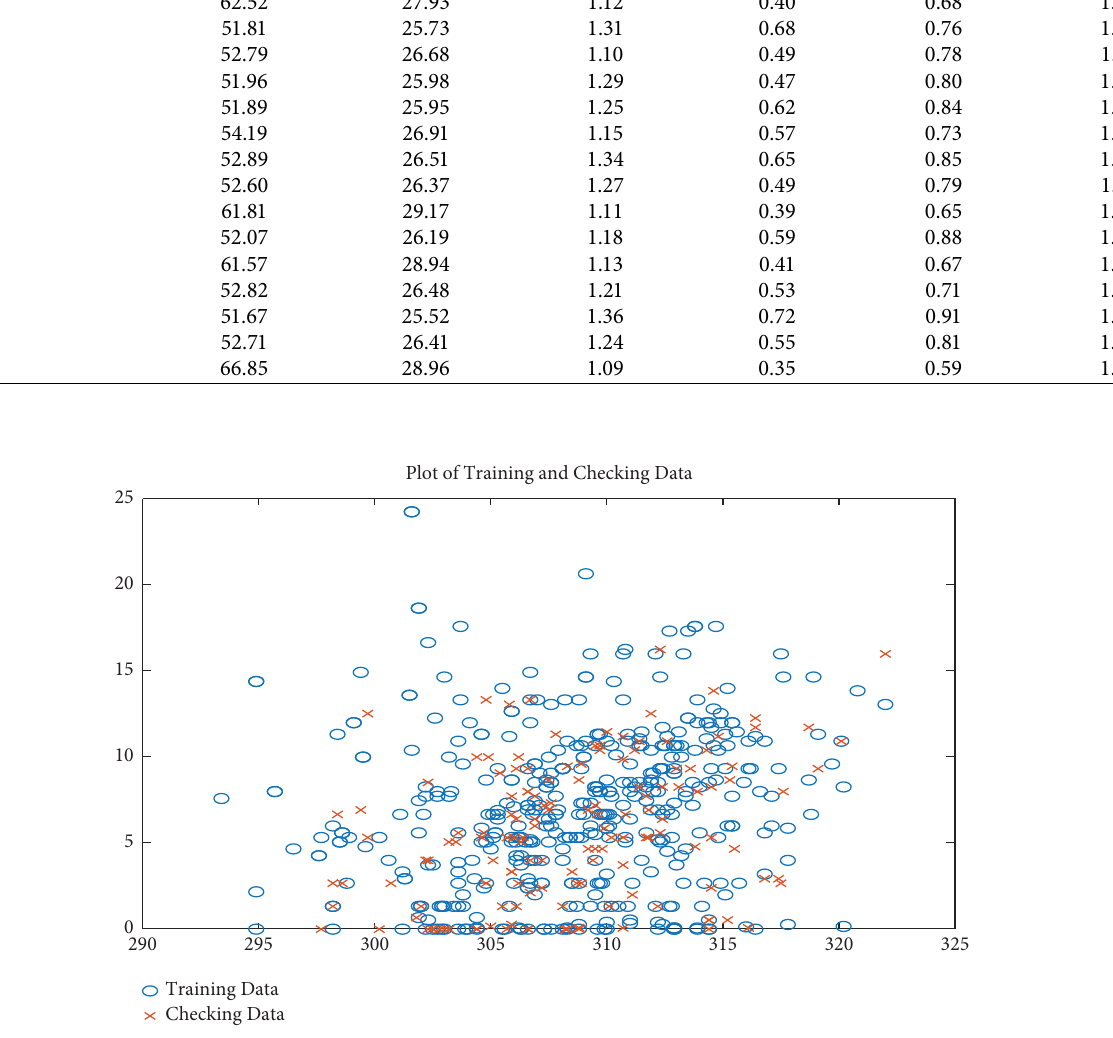
Figure 4: Scatter diagram of both the training and checking data. Table 6: Optimization of ANFIS